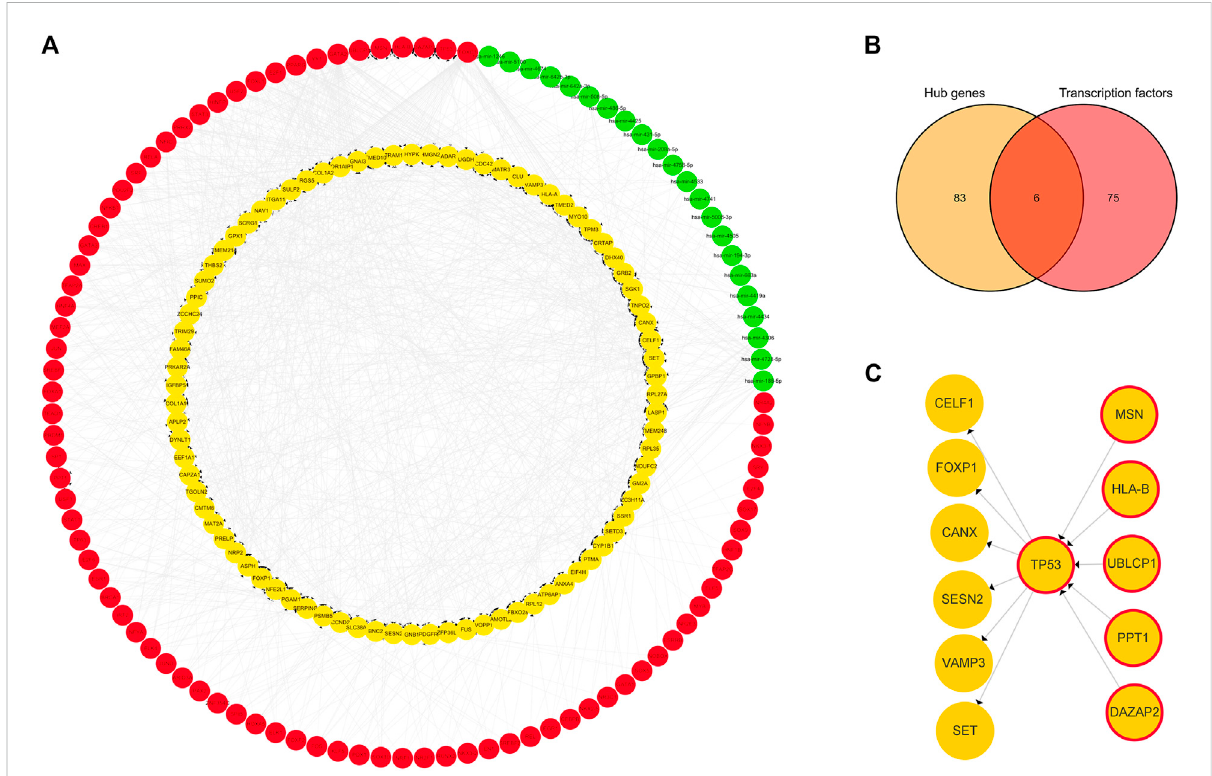
FIGURE 5 TF-hub gene-miRNA network. (A) Red nodes represent TFs, green nodes represent miRNAs, and yellow nodes represent hub genes. (B) Venn diagram of hub genes acting as TFs in IDD. (C) Yellow nodes represent hub genes, and yellow nodes with red borders represent hub genes acting as transcription